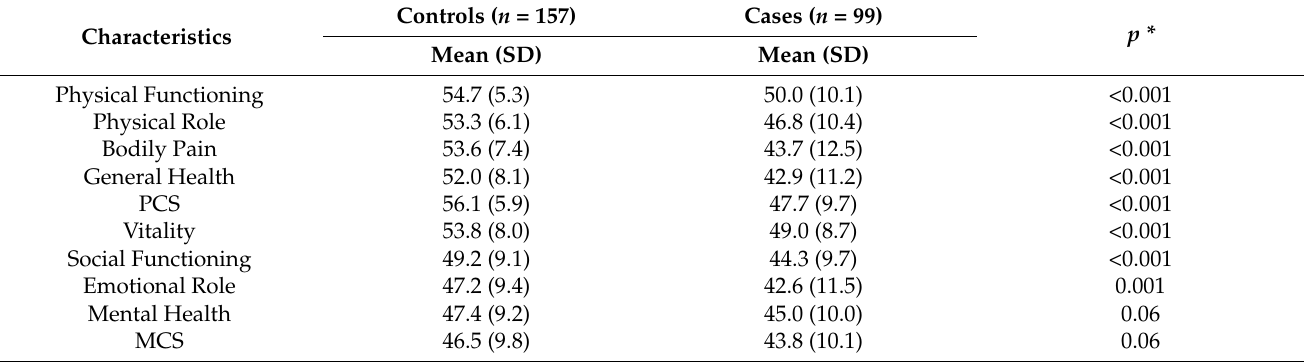
Table 3. Comparison of the norm-based scales and summary measure scores of SF-12v2 between cases and controls. Characteristics